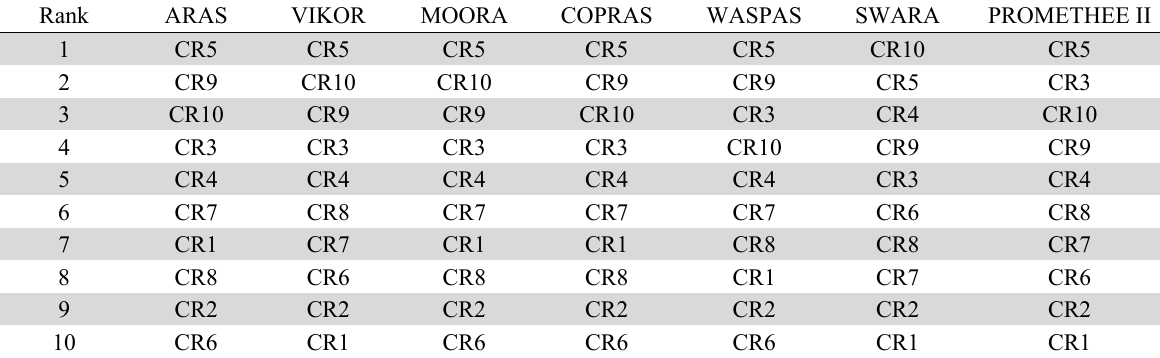
Table 5 Rank of the contractors by MCDM methods